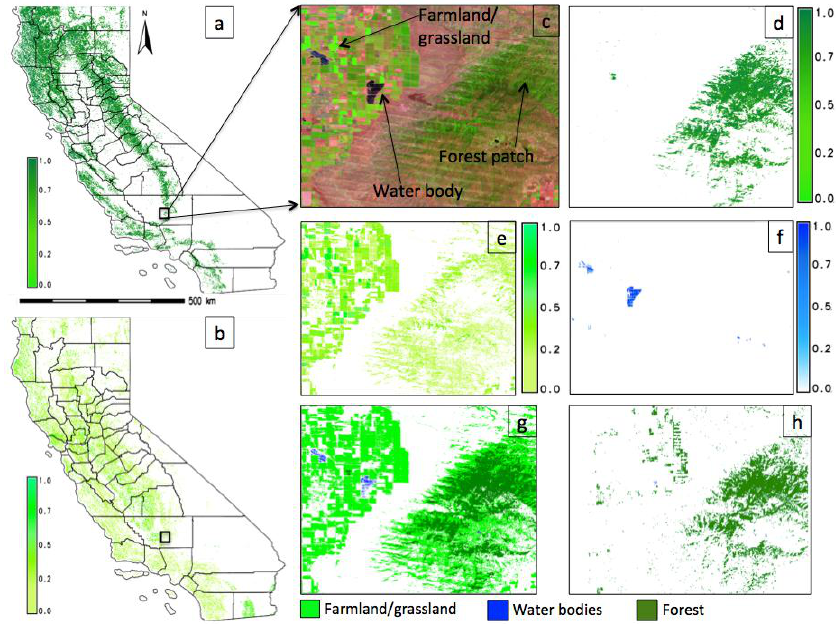
Figure 7. ( a ) Forest fractional map and ( b ) farmland/grassland fractional map for the state of California. ( c ) FCC (false color composite) from Landsat (bands 5-4-3 as Red-Green-Blue) showing forest patch, grassland and water bodies; ( d ) forest fractional map for the corresponding area in ( c ); ( e ) farmland/grassland fractional map; ( f ) water fractional map; ( g ) classification of original WELD data by RF (Random Forest); and ( h ) forest cover map from NAFD (North American Forest Dynamics) product.